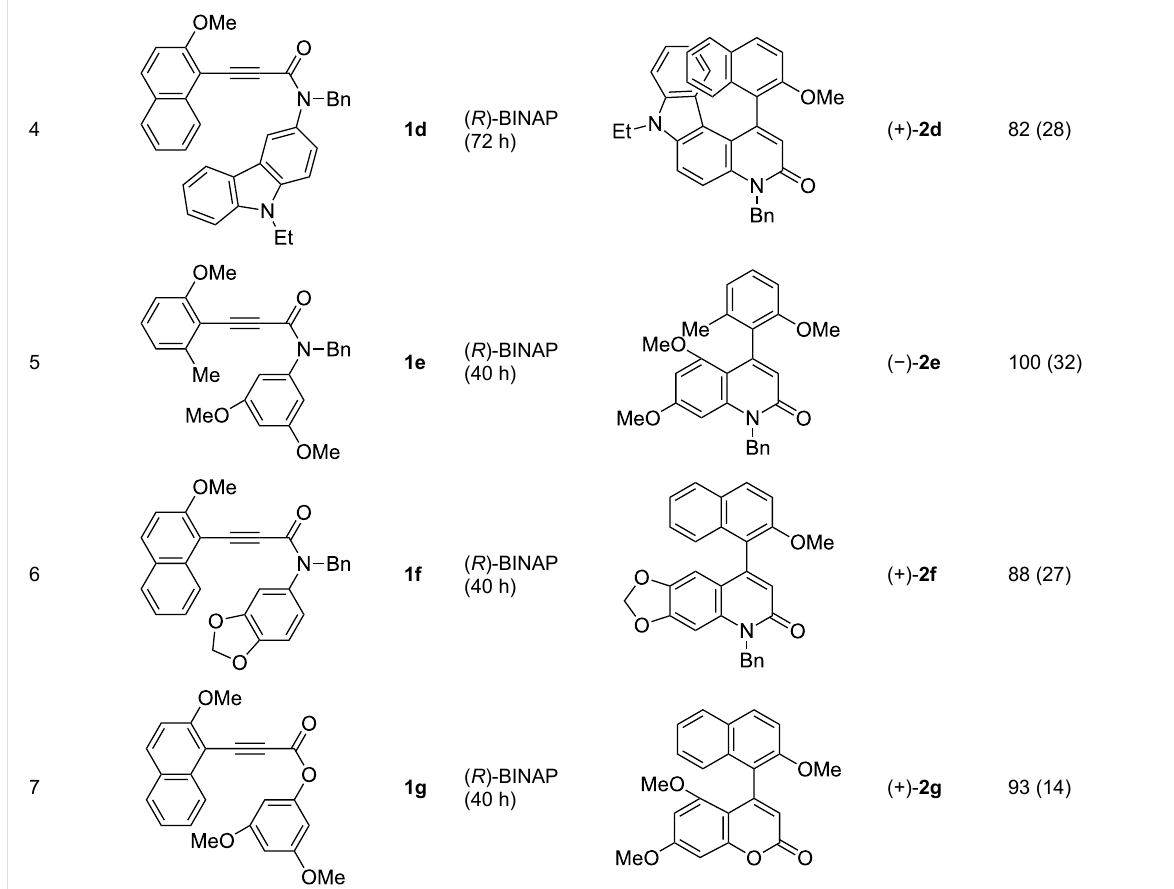
Table 2: Cationic gold(I)-complex catalyzed atropselective intramolecular hydroarylation of 1a – g leading to heterobiaryls 2a – g . a